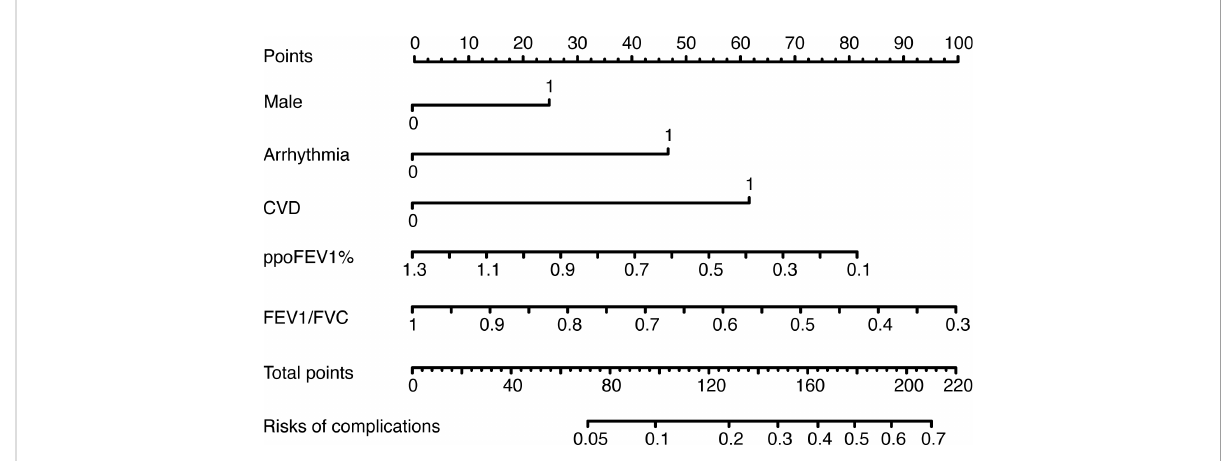
FIGURE 3 The nomogram of the logistic model. CVD, cerebrovascular disease; ppoFEV1%, the percentage of predicted postoperative forced expiratory volume in one second; FEV1/FVC, the ratio of forced expiratory volume in one second to forced vital